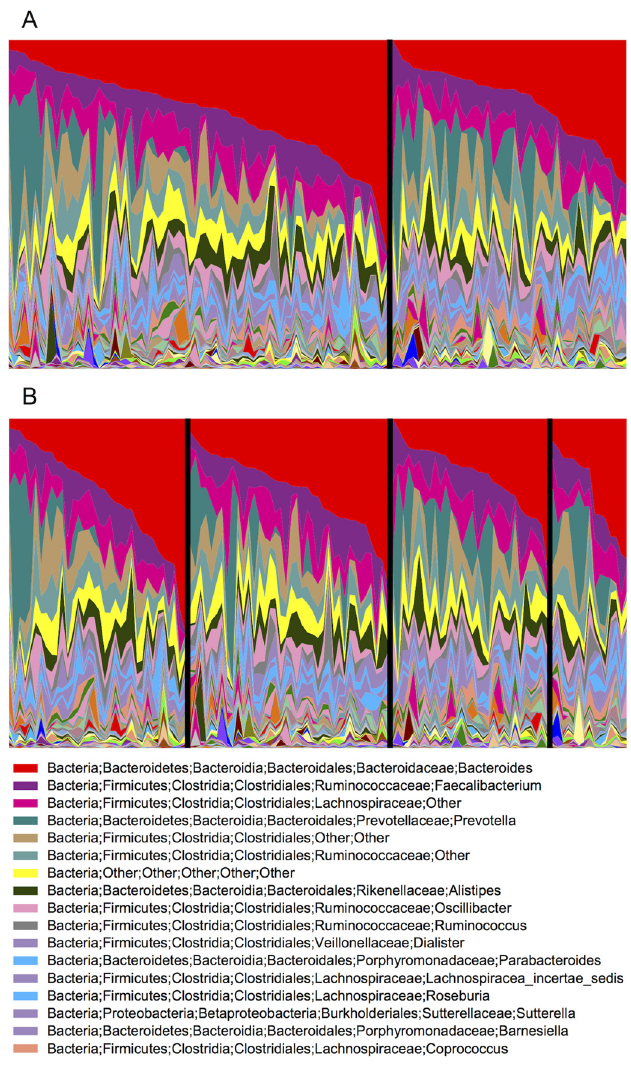
Fig 4. Genus level taxonomic distribution in 117 Norwegian stool samples according to ancestral HLA haplotype AH8.1 status. (A) The genus abundances sorted according to the relative abundance of Bacteroides , of n = 72 AH8.1 carriers (left) are shown compared with the n = 45 non-AH8.1 samples (right). In (B) the genus abundances are shown according to all four pre-defined genotype groups; Left: AH8.1 homozygotes, i.e. homozygosity for both HLA-B * 08 and HLA-DRB1 * 03; Middle left: AH8.1 heterozygotes, i.e. at least 1 copy of HLA-B * 08 and HLA-DRB1 * 03; Middle right: Non AH8.1 heterozygotes, i.e. HLA-B * 08 and HLA-DRB1 * 03 both not present; Right: HLA-DRB1 homozygous but non